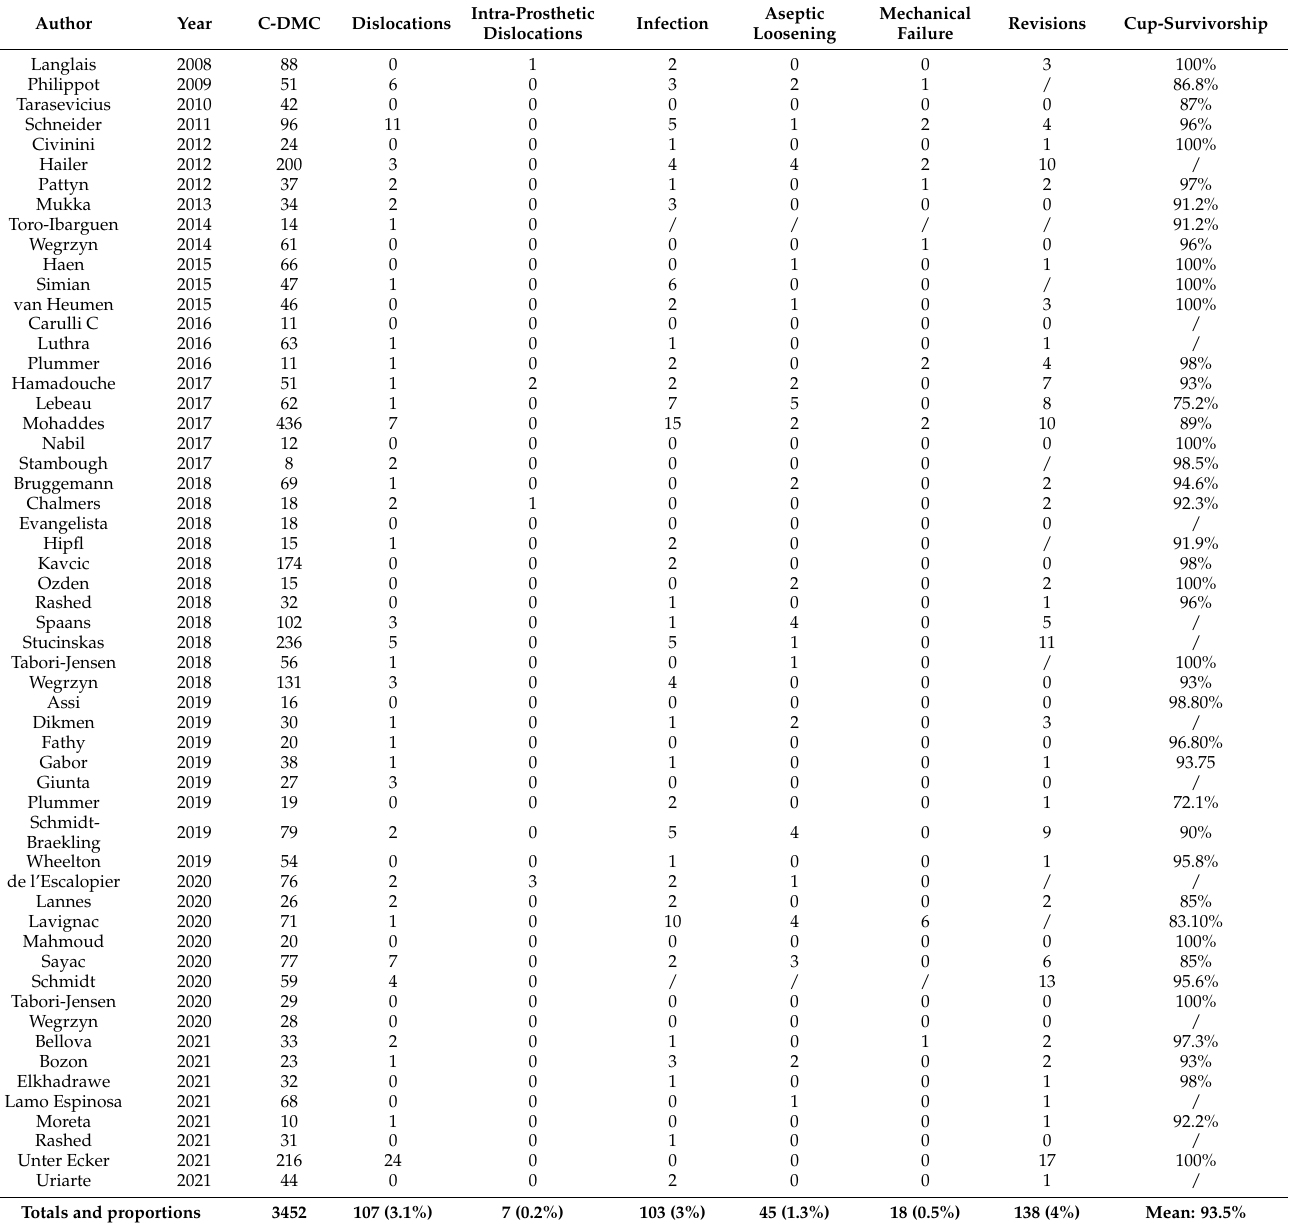
Table 4. Cemented dual mobility cup: